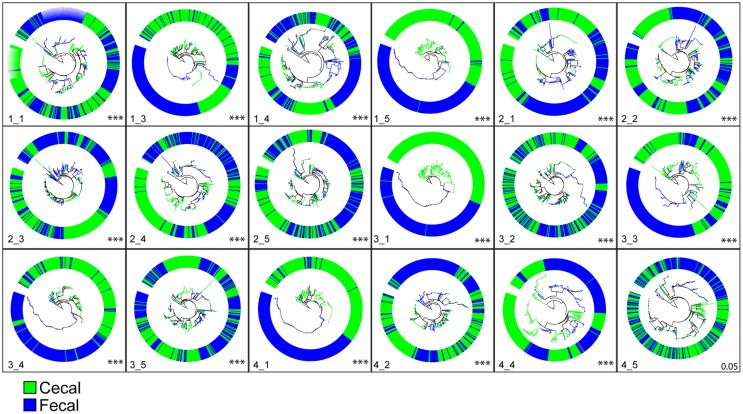
Phylogenetic clustering of cecal versus fecal bacterial communities from birds at 1 week of age (n = 18). Each circle represents a phylogenetic tree of cecal and fecal samples taken from a single bird. For each bird, 250 sequences were randomly sampled from each sample type, phylogenies constructed in ARB, and unique versus shared branch lengths compared using Unifrac as described in the methods section. All comparisons were highly significant (p < 0.0001; indicative of phylogenetic clustering) except for bird 4_5 shown in the lower right (p = 0.054). Results for weeks 3 and 6 showed similar results. Comparisons of genera significantly over-represented in fecal samples relative to cecal samples showed Lactobacillus and Gallibacterium were the most abundant while the genera Bacteroides, Pseudoflavonifractor, Oscillibacter, Flavonifractor, and Subdoligranulum were significantly more abundant in the ceca than in feces.